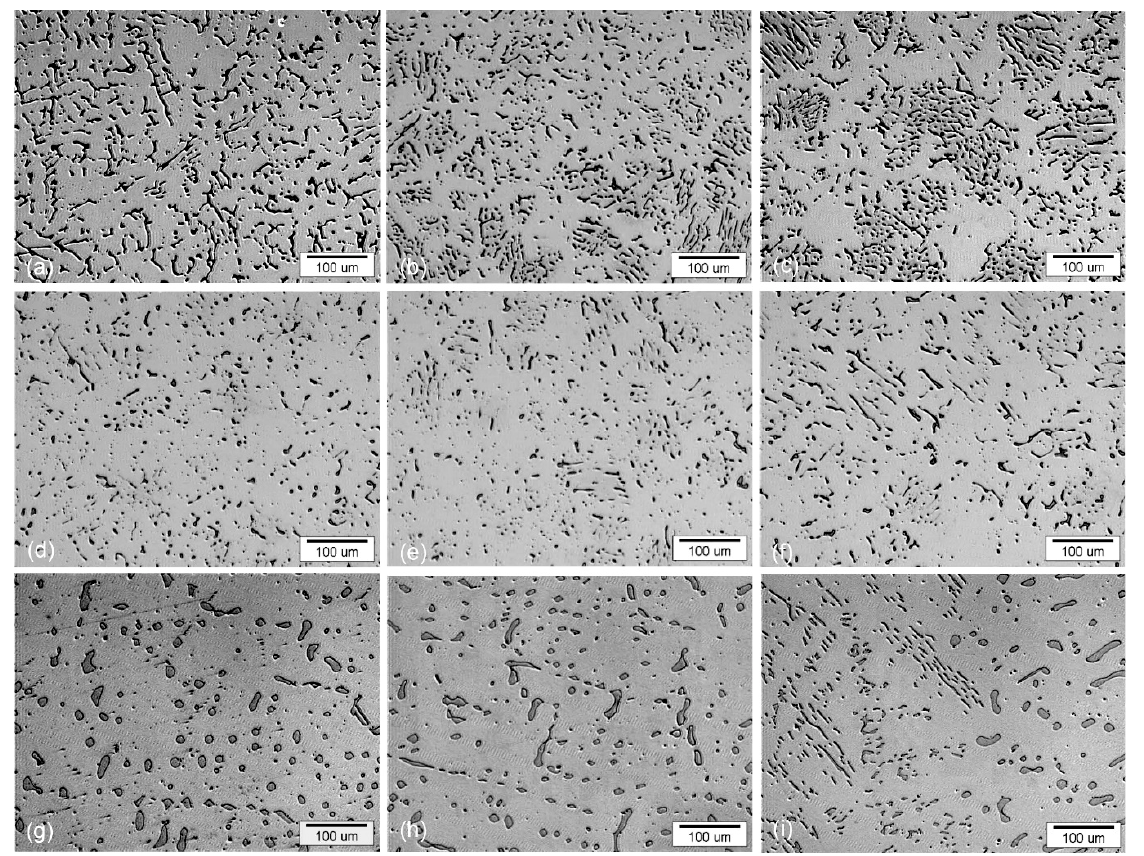
Figure 5. Evolution of morphology of δ -ferrite in microstructure after 5 min annealing at 1050 °C ( a – c ), 1150 °C ( d – f ), and 1250 °C ( g – i ). Locations are 3 mm ( a , d , g ), 10 mm from the edge ( b , e , h ), and center of the ingot ( c , f , i ).